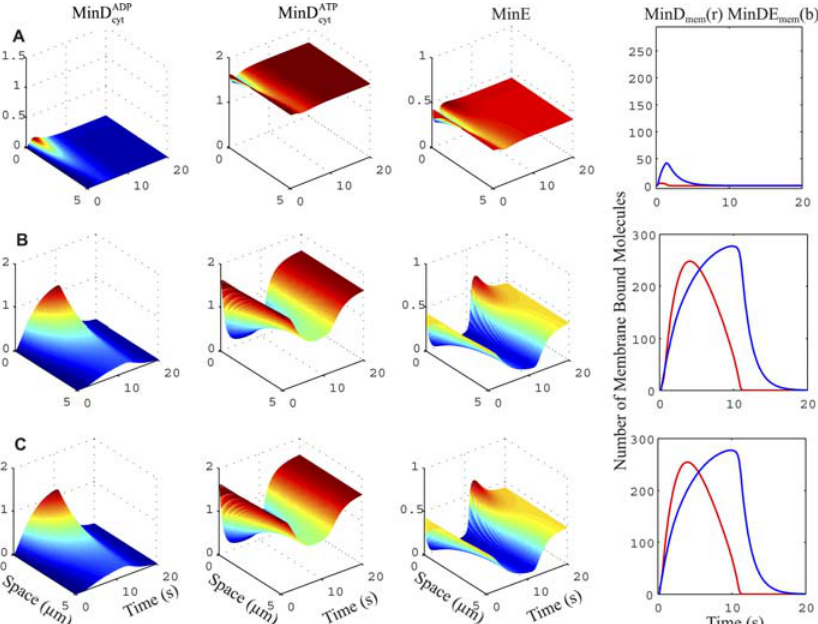
Figure 9. Deterministic Time Evolution for Cluster Formation in the PE (cid:1) Phenotype The mean-field equations with PE (cid:1) parameters were solved for a box (5 l m 3 1 l m 3 1 l m), with membrane on one of the 1- l m 3 1- l m sides. The simulations were initialized with a membrane occupancy of MinD corresponding to 5, 7.5, and 10 molecules in the center of the membrane for (A), (B), and (C), respectively. The right-most column displays how the number of membrane-bound MinD (red) and MinDE (blue) complexes change in time. In the other plots, we see the concentrations of the cytosolic proteins at different distances from the membrane for different points in time. DOI: